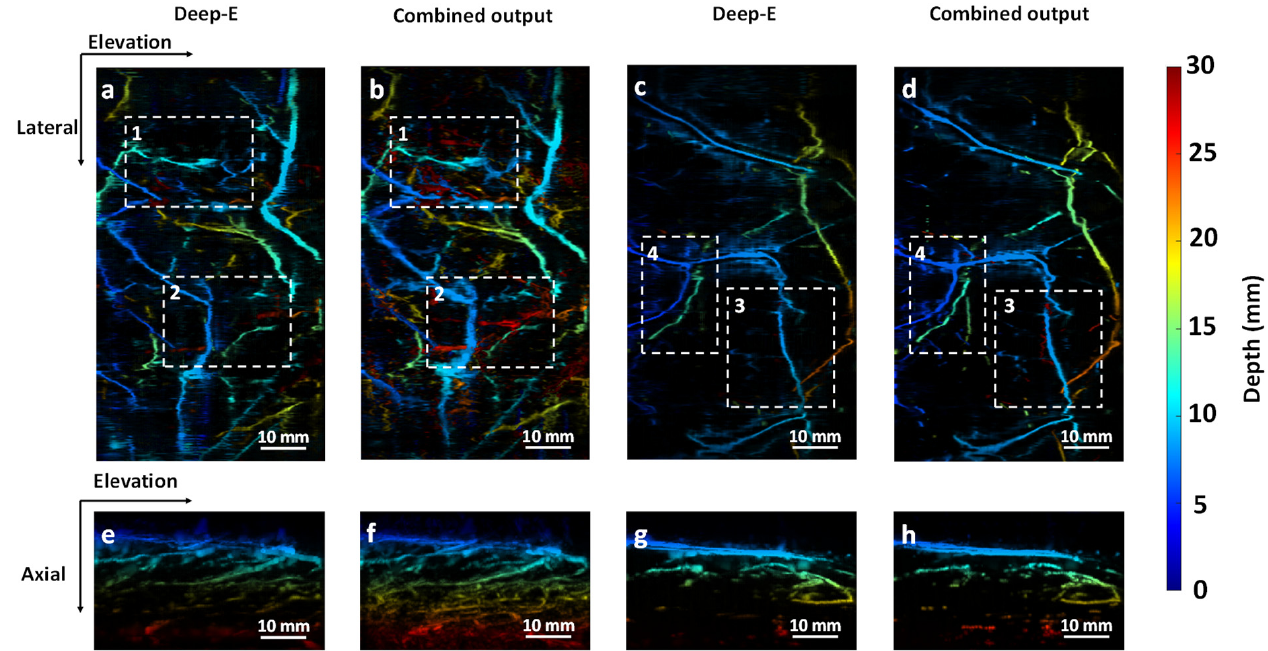
Figure 8. Comparison between 2D Deep-E and combined (2D Deep-E and 3D Deep-E) output. ( a ) Sub- ject 1 output image from 2D Deep-E. ( b ) Subject 1 output image from the combined approach. ( c ) Sub- ject 2 output image from 2D Deep-E. ( d ) Subject 2 output image from the combined approach. ( e ) Cross-section MAP image of ( a ). ( f ) Cross-section MAP image of ( b ). ( g ) Cross-section MAP image of ( c ). ( h ) Cross-section MAP image of ( d ).